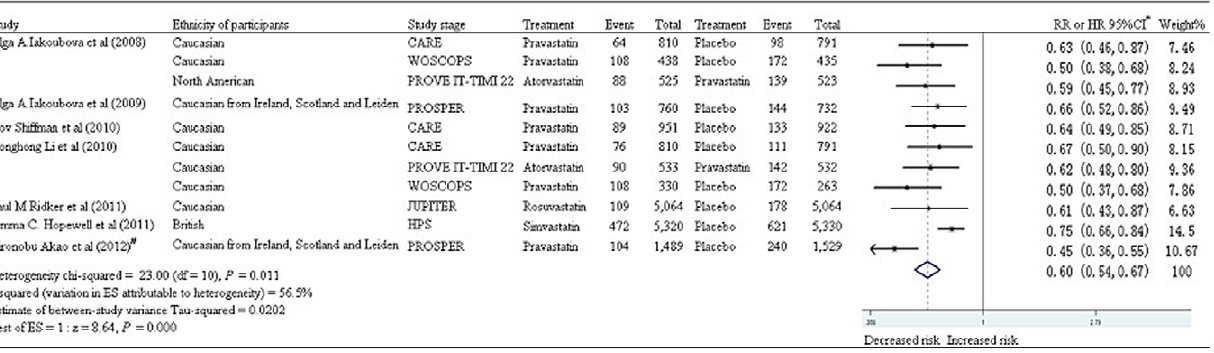
Figure 3. Meta-analysis between Trp719Arg and statin therapy. *: Reference allele is 719Arg; Weights are from random effects analysis; # : The study’s RR is calculated using the SPSS statistical software (version